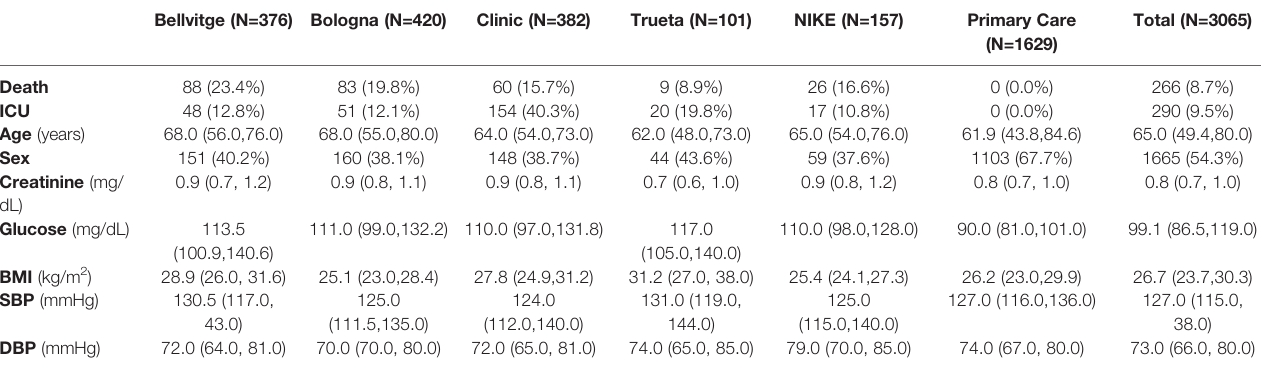
TABLE 1 | Characteristics of the patients included in each